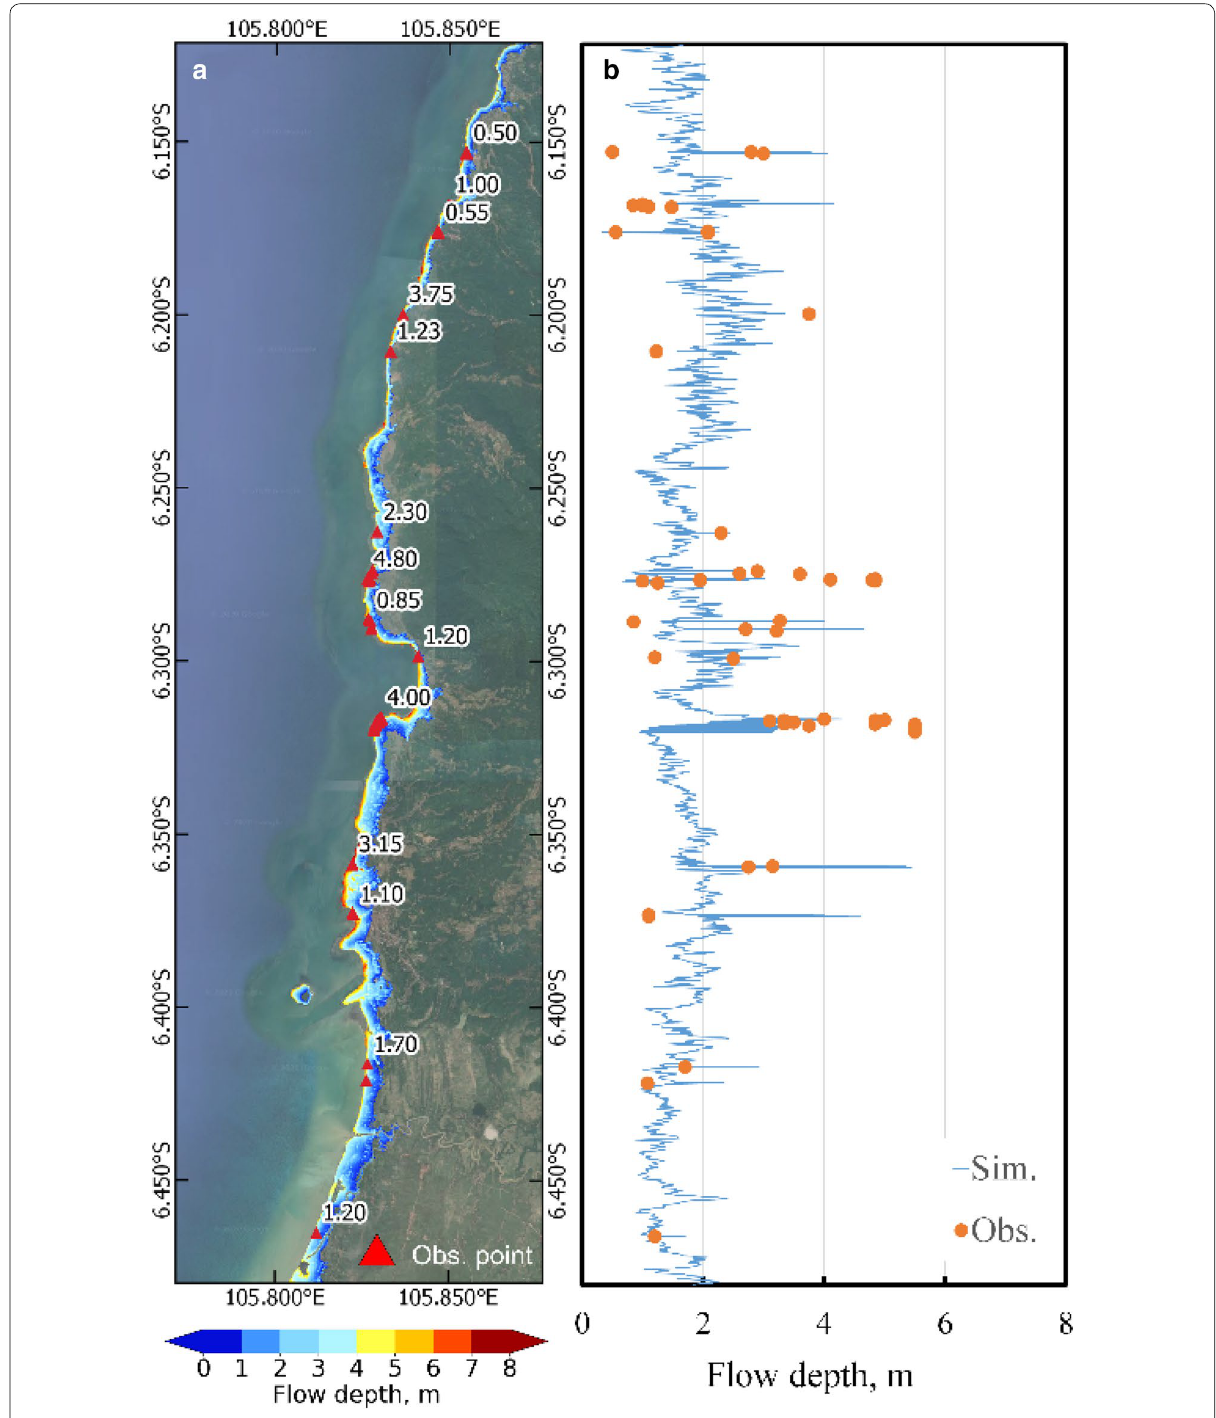
Fig. 12 Impact of the tsunami along the coastline in area A: a flood extent and locations of survey points; b water level along the coastline and comparison with observation